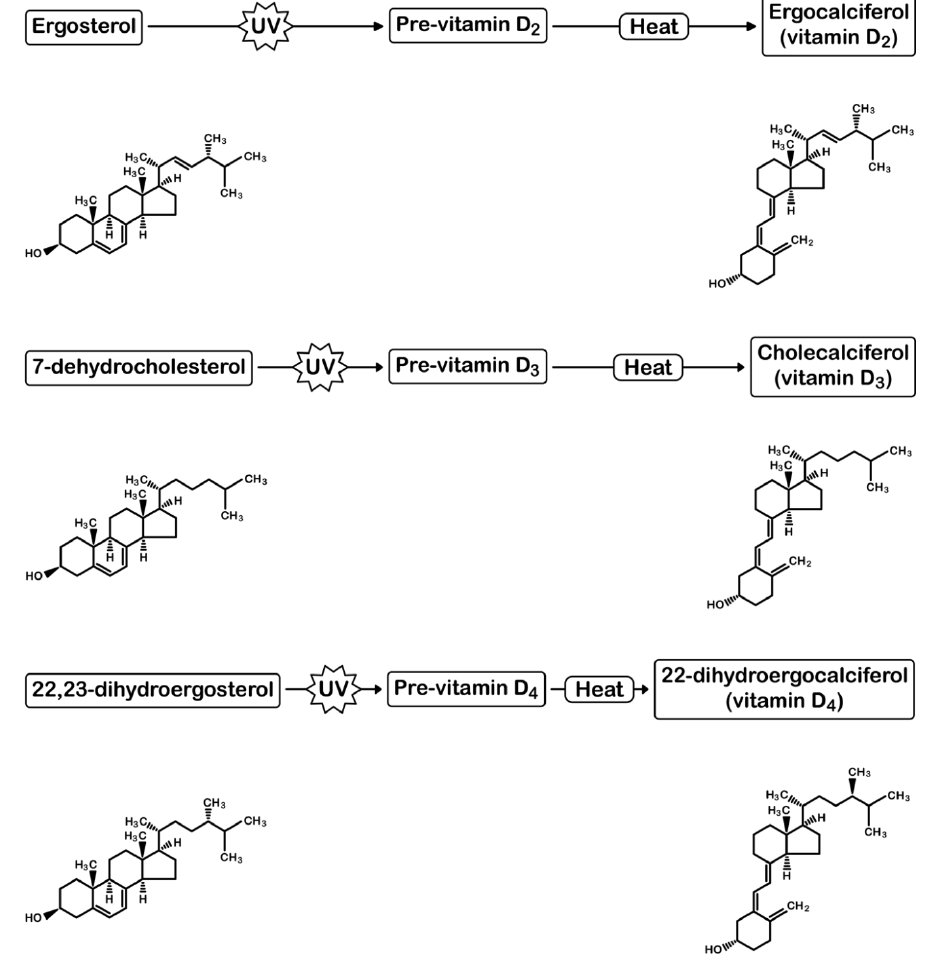
Figure 1. Structures of vitamin D 2 , D 3 , D 4, and their precursors. UV, ultraviolet radiation.